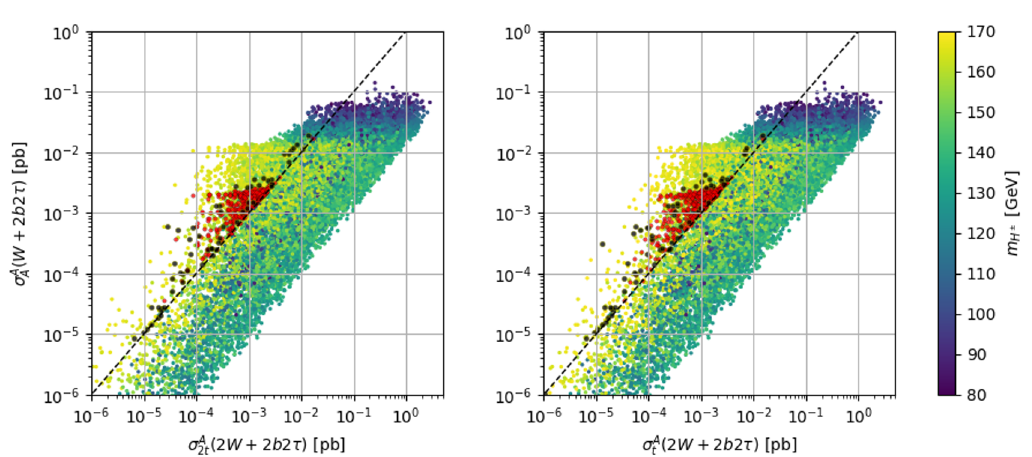
¯ Figure 5 . Values of 2 σ ( pp → H ± A ) × BR( H ± → W ± A ) × BR( A → b b ) × BR( A → τ + τ − ) ¯ are compared with those of 2 σ × BR( t → bH + ) × BR(¯ t → bW − ) × BR( H ± → W ± A ) × t ¯ t BR( A → τ + τ − ) (left) and σ ( pp → t ¯ bH − ) × BR( t → bW + ) × BR( H ± → W ± A ) × BR( A → τ + τ − ) (right). The red points identify the values of σ ( H + H − ) × BR( H ± → W ± A ) 2 × BR( A → b ¯ b ) × BR( A → τ + τ − ) which also exceeds those of the latter two top mediated processes, respectively. The colour bar denotes the mass of the charged Higgs boson. Results are for the 2HDM Type-I with the exception of the black points, which refer to the 2HDM Type-X rates for σ ( pp → H ± A ) × BR( H ± → W ± A ) × BR( A → τ + τ − ) 2